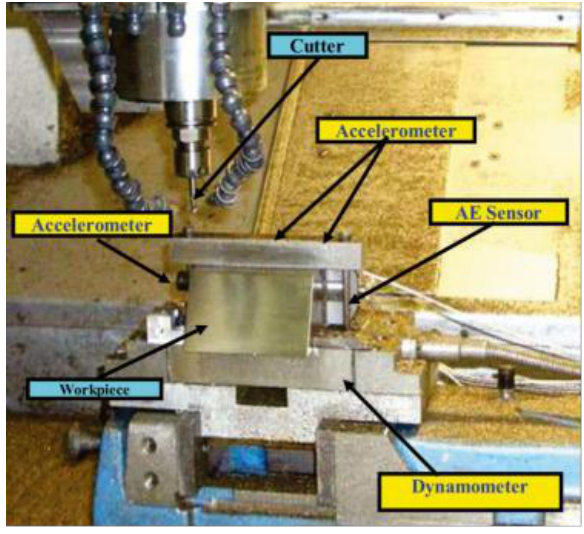
Figure 3. The experimental setup.